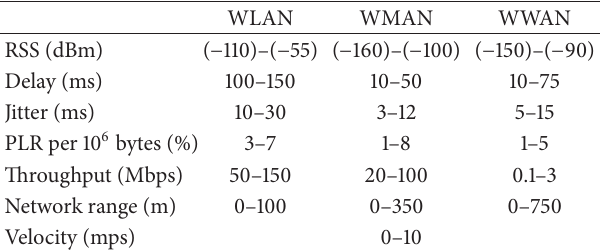
Figure 1: VHONE block diagram.